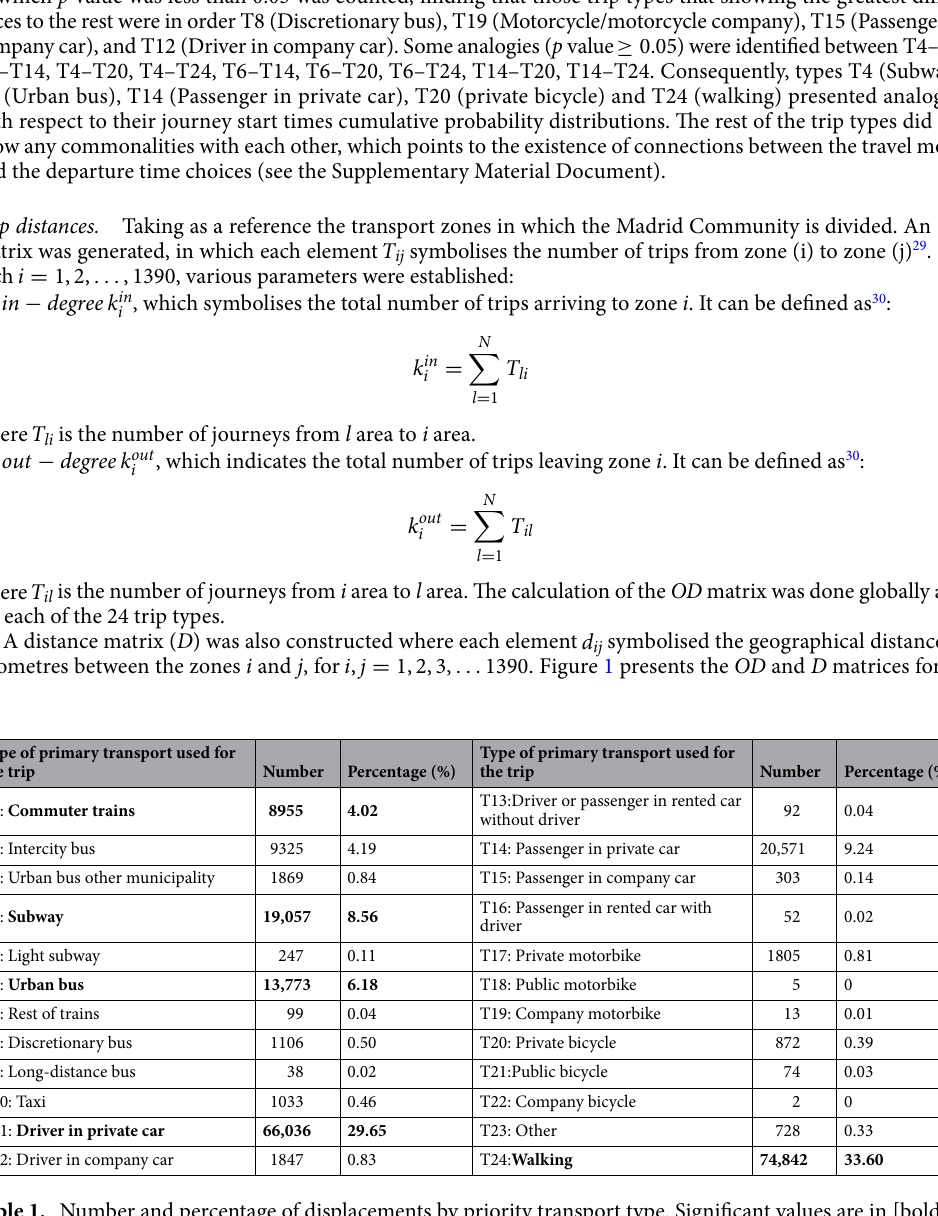
Table 1. Number and percentage of displacements by priority transport type. Significant values are in [bold].